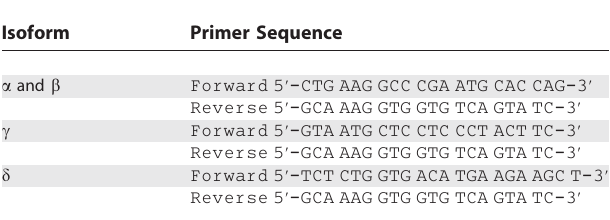
Table 1. Primer Sequences Used in the RT-PCR for the Four Isoforms of IL-32 Isoform Primer